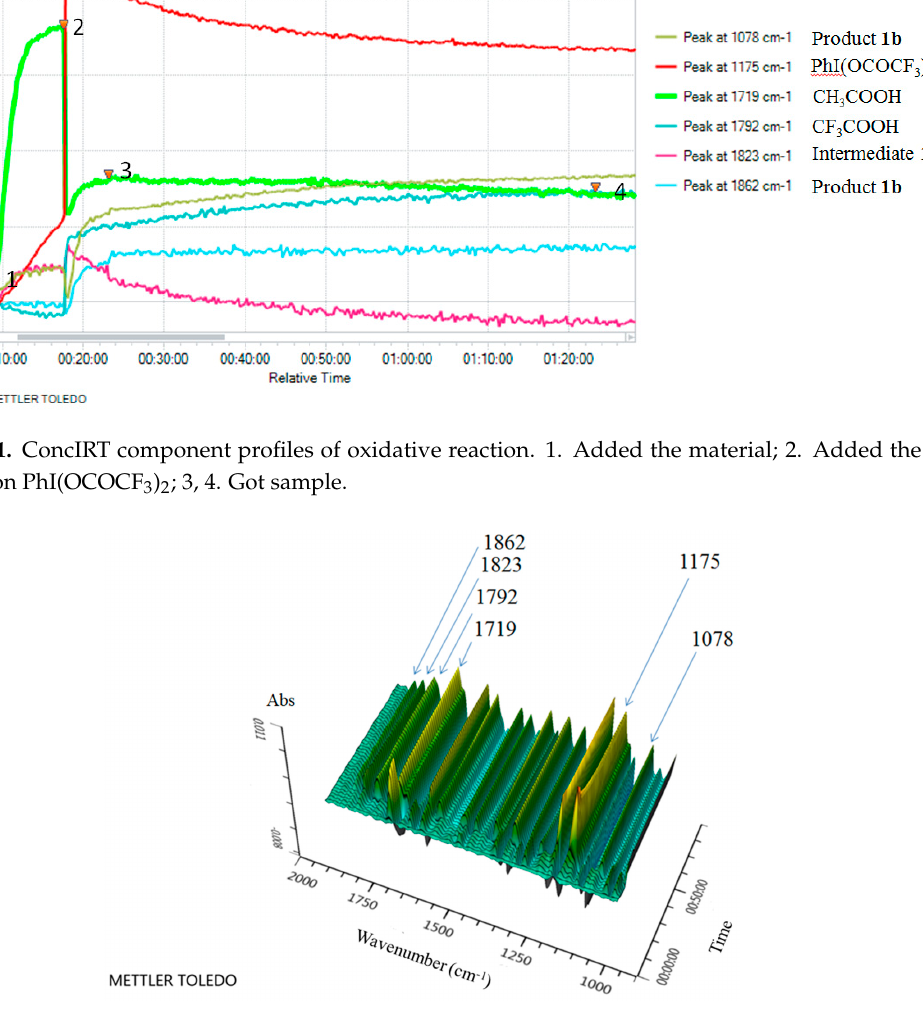
Figure 2. In situ reaction of IR, 3D surface plot of oxidative reaction.